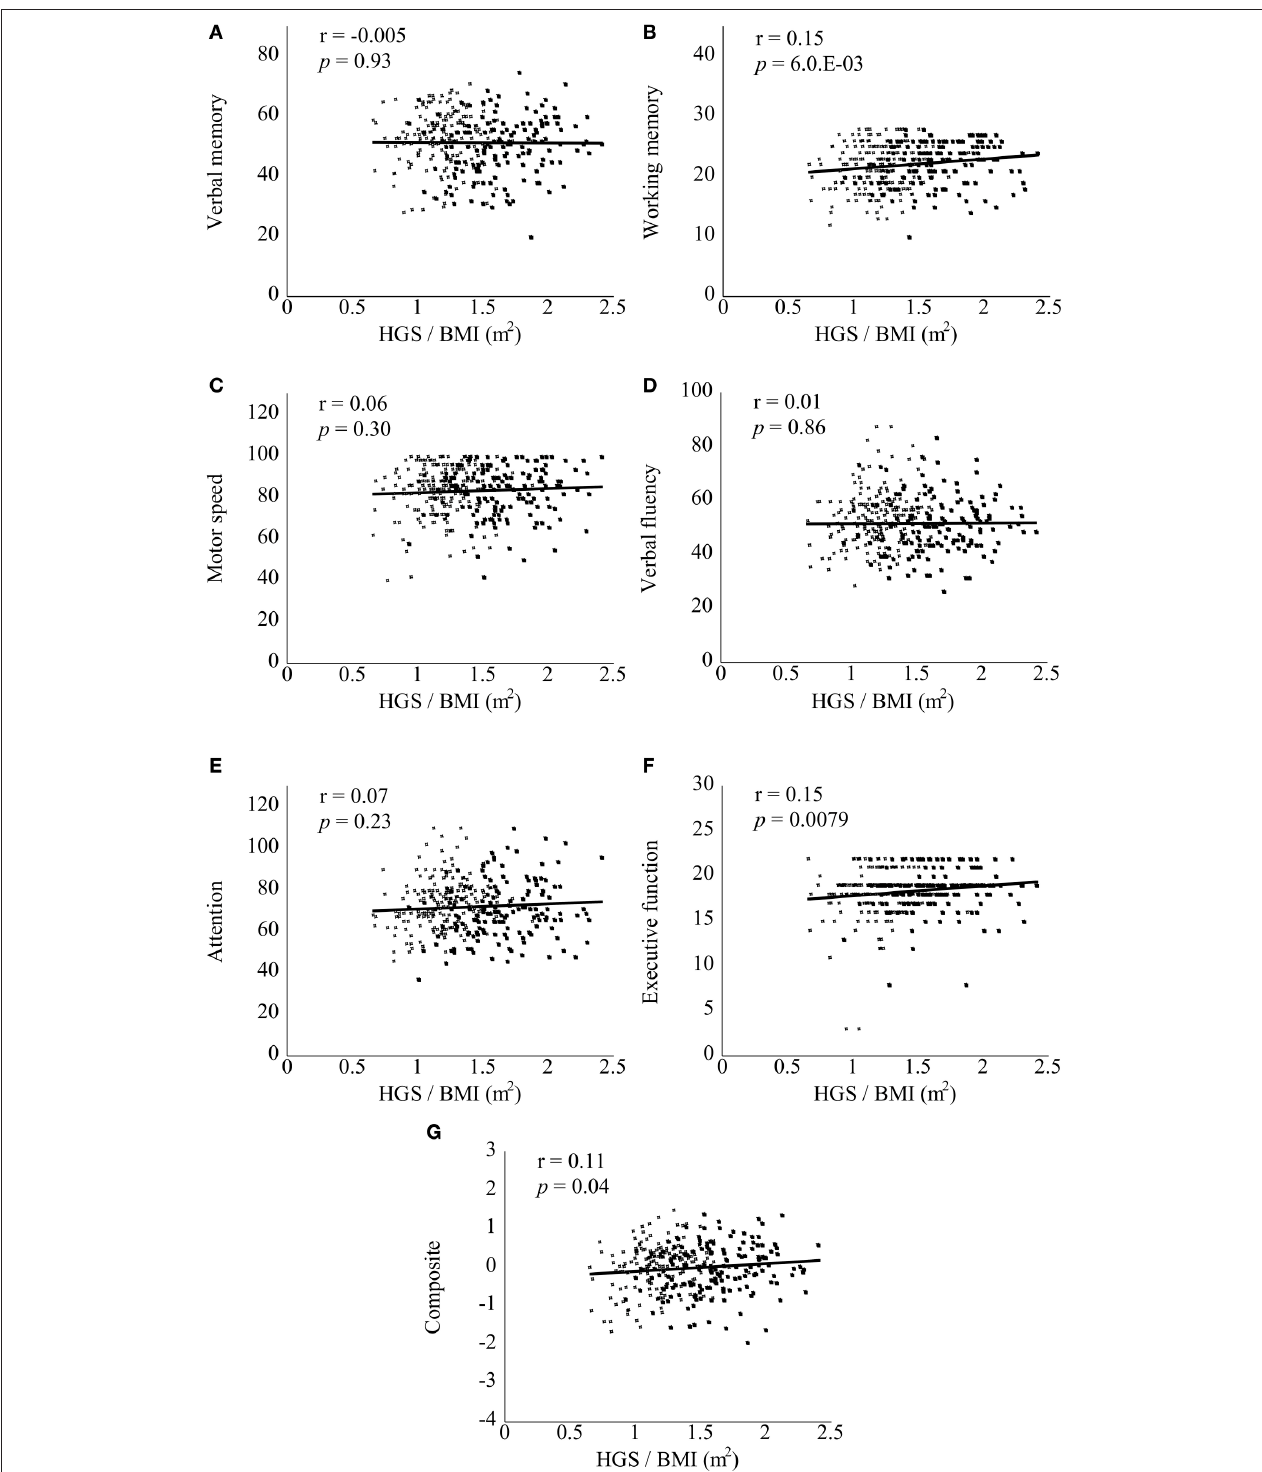
FIGURE 2 | Scatter plots of correlations between handgrip strength (HGS)/body mass index (BMI) and Brief Assessment of Cognition in Schizophrenia (BACS) scores in healthy controls. HGS/BMI positively correlated with only the BACS working memory score ( B , not A or C–G ) in the controls ( p < 0.0071, corrected for multiple testing). Black and white squares indicate male and female controls, respectively. A significant p -value is shown in an exponent. r, Pearson’s correlation coefficient.